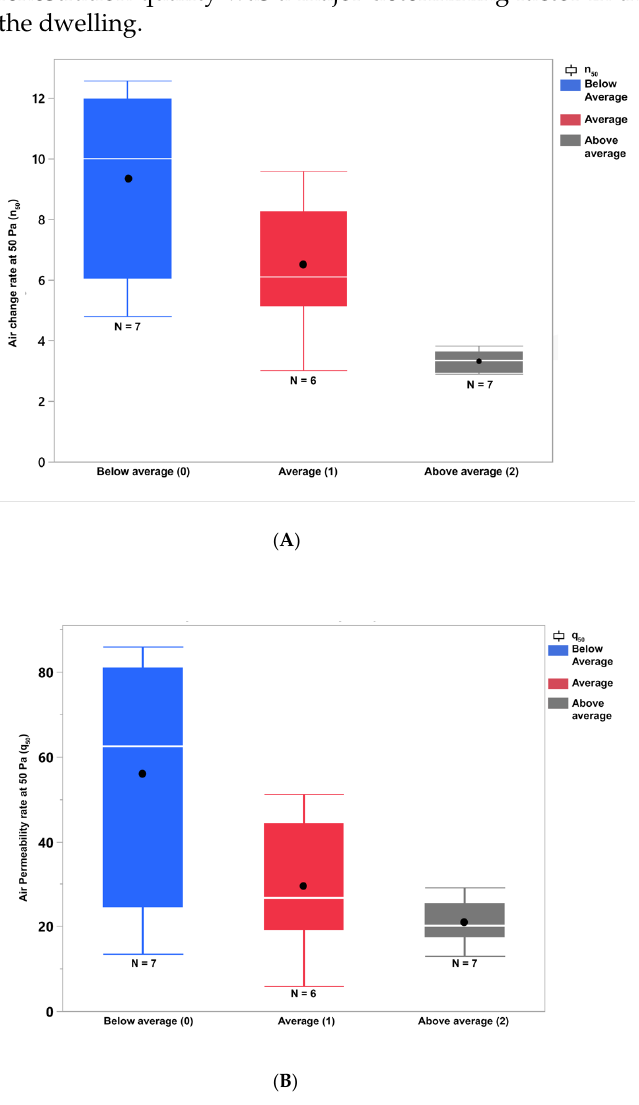
Figure 11. Box and whisker plots showing the distribution of ( A ) n 50 and ( B ) q 50 based on the different observed fenestration quality (dots show the mean value).